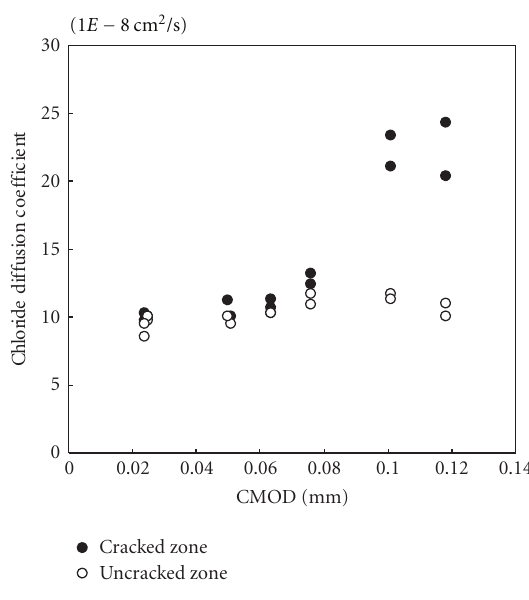
Figure 13: Chloride di ff usion coe ffi cient for PCT treated concrete.